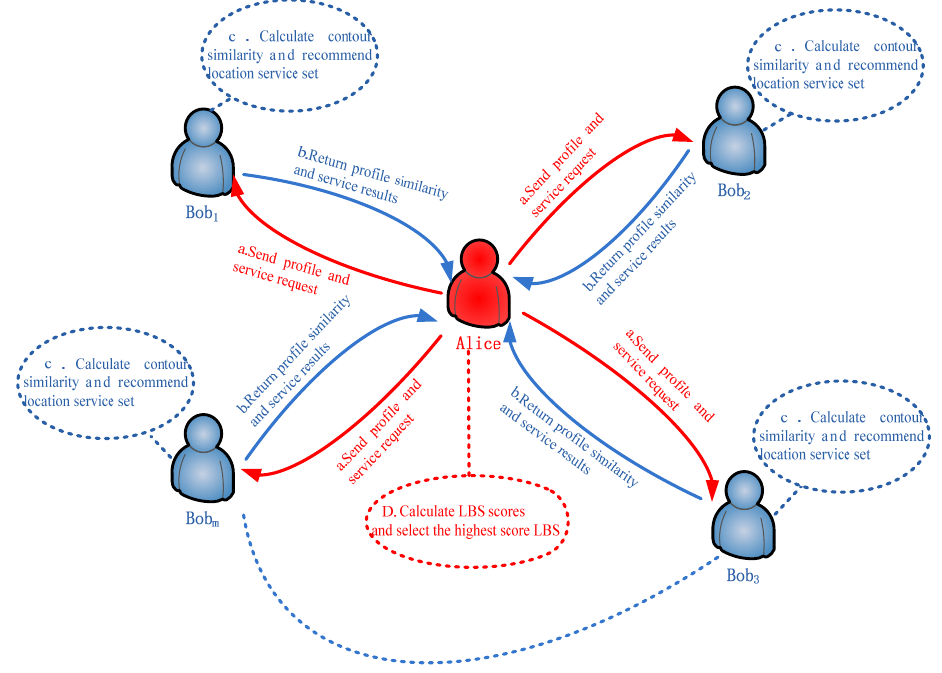
Figure 4. Collaborative filtering recommendation algorithm based on position profile.